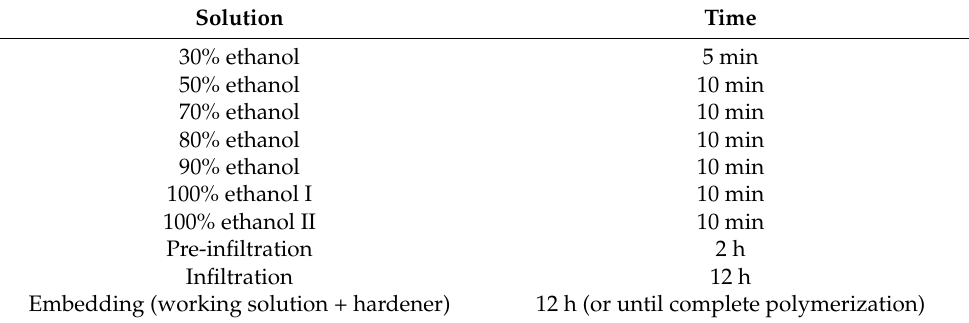
Table 6. Summary of procedures in historesin processing.